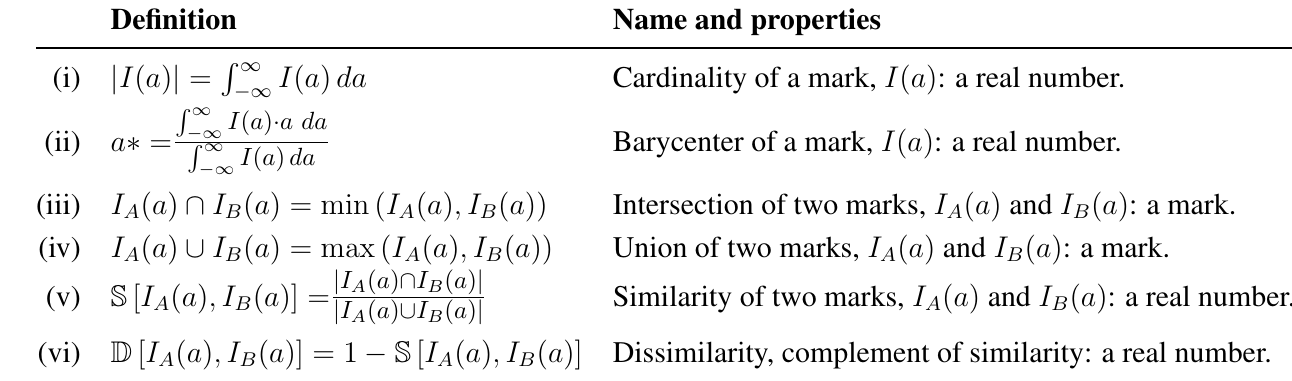
Table 1. Basic definitions for assessing the similarity of